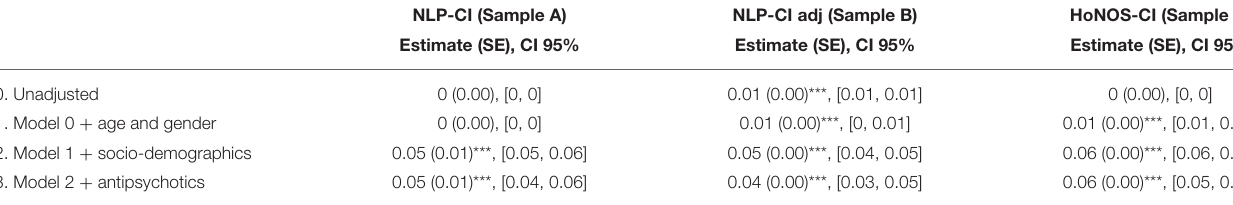
TABLE 7 | Slope estimates for the fully adjusted linear mixed model for HoNOS-CI and NLP-CI trajectories. NLP-CI (Sample A) NLP-CI adj (Sample B) HoNOS-CI (Sample